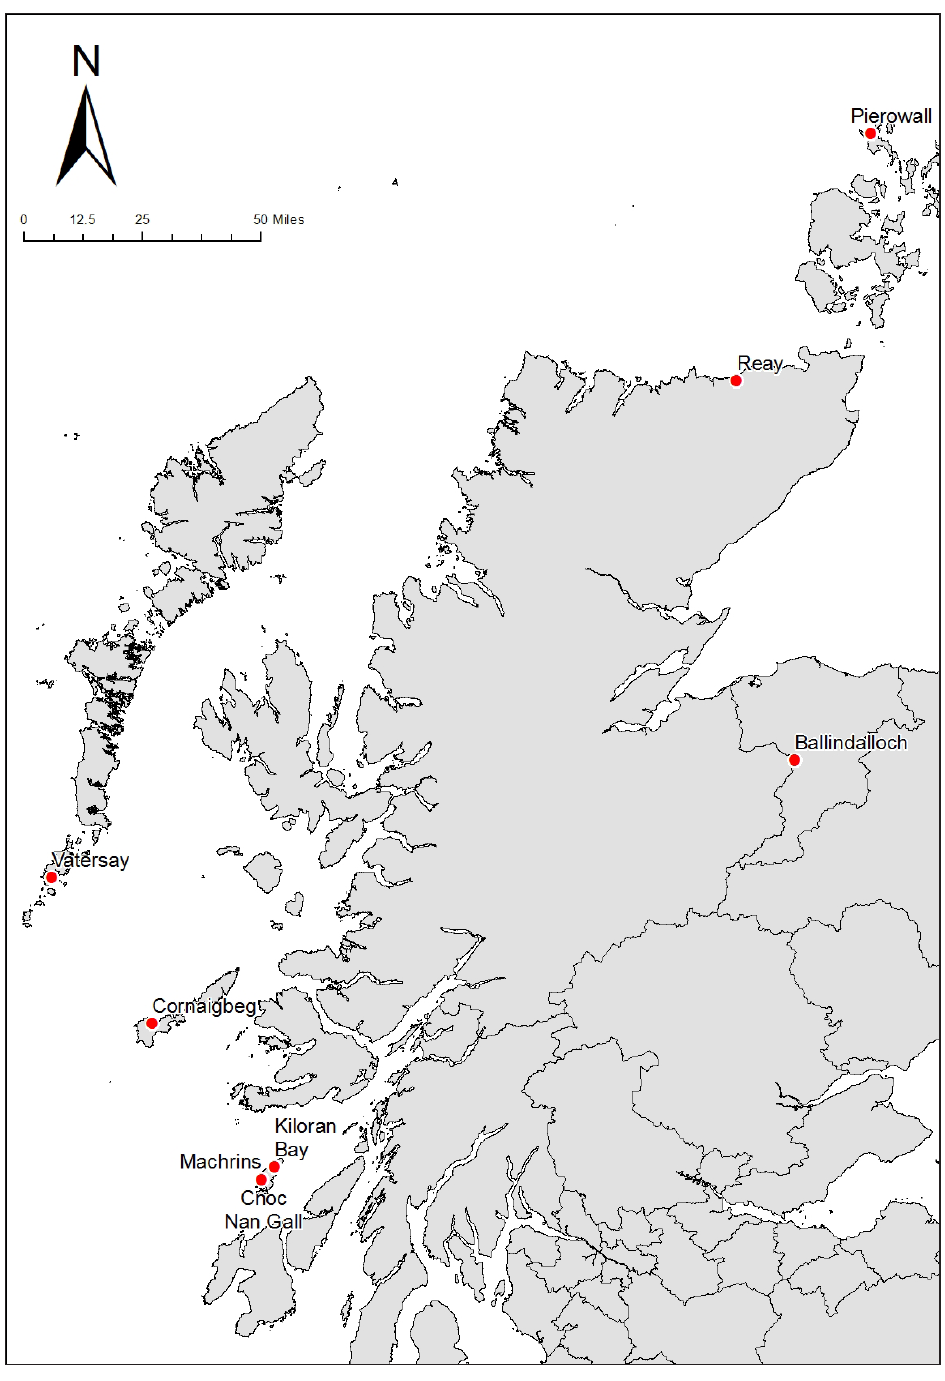
Figure 1: Distribution map of pagan Viking burials containing horse